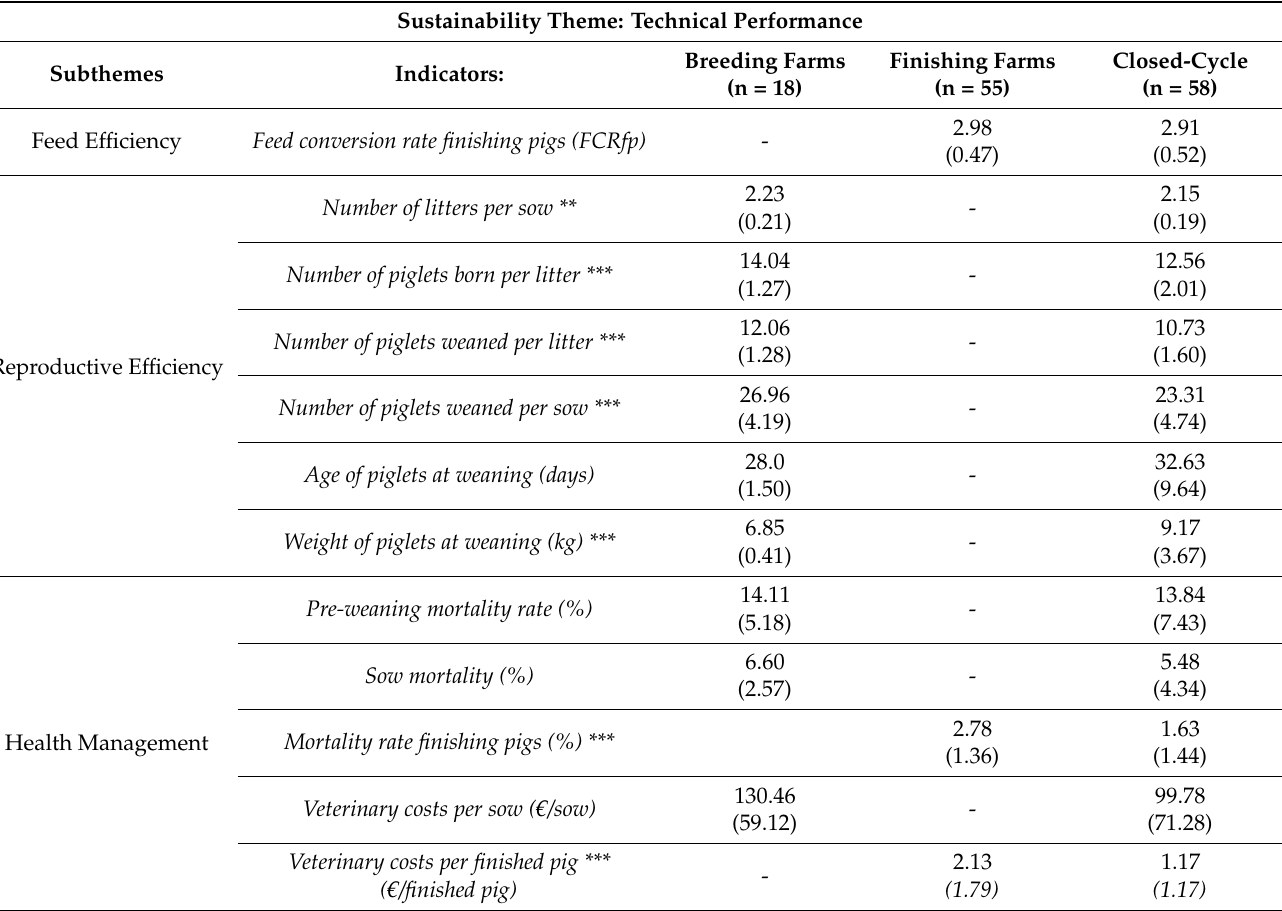
Table 4. Technical performance indicators across farm types (values and standard deviations). Sustainability Theme: Technical